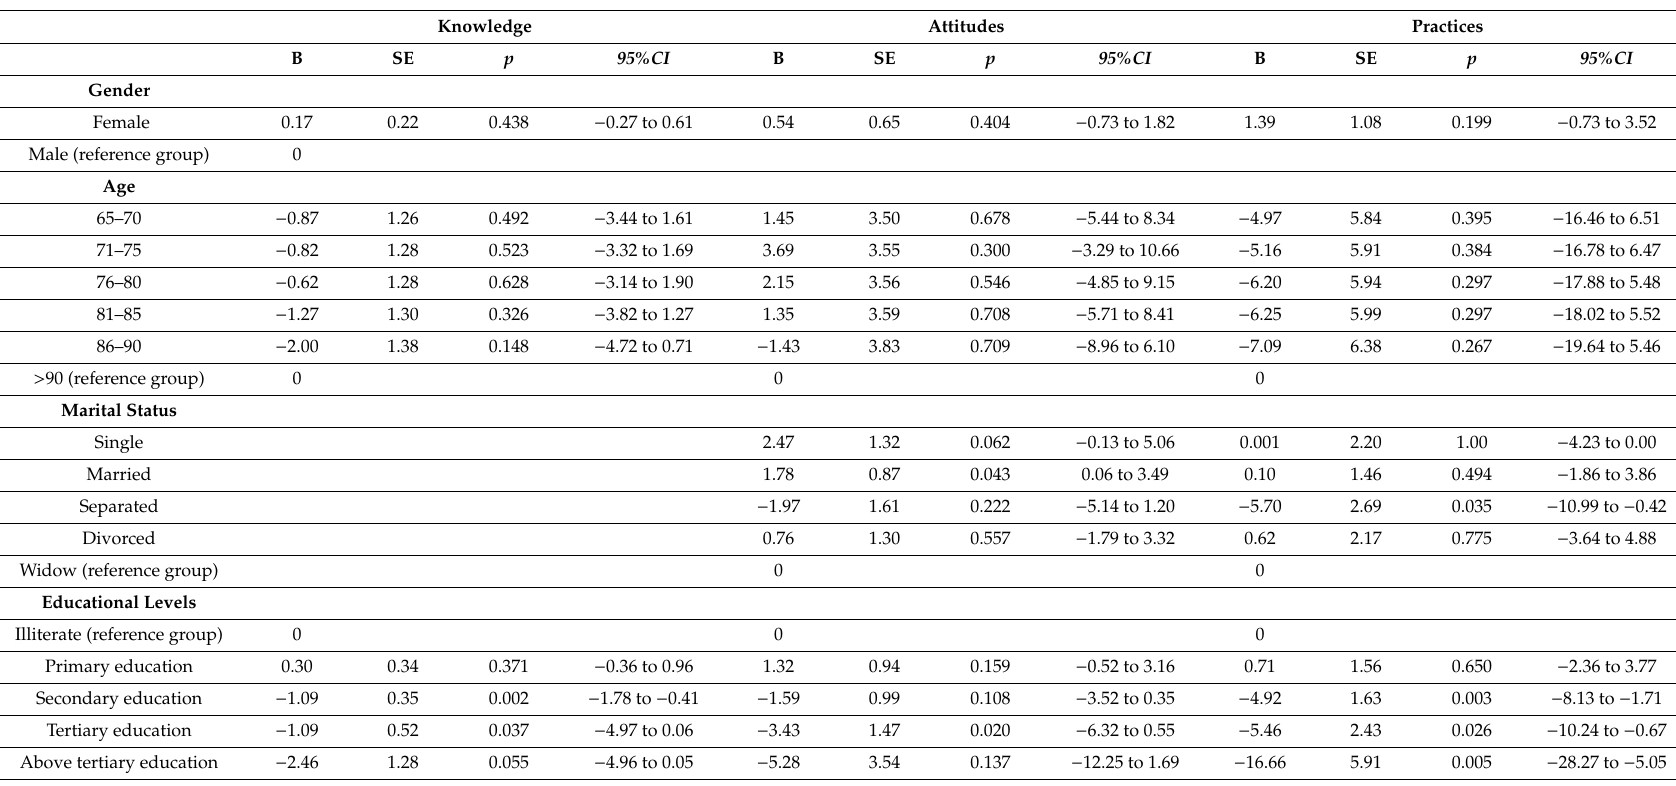
Table 5. Results of univariate regression for each factor associated with KAP of oral care among elderly people (n =